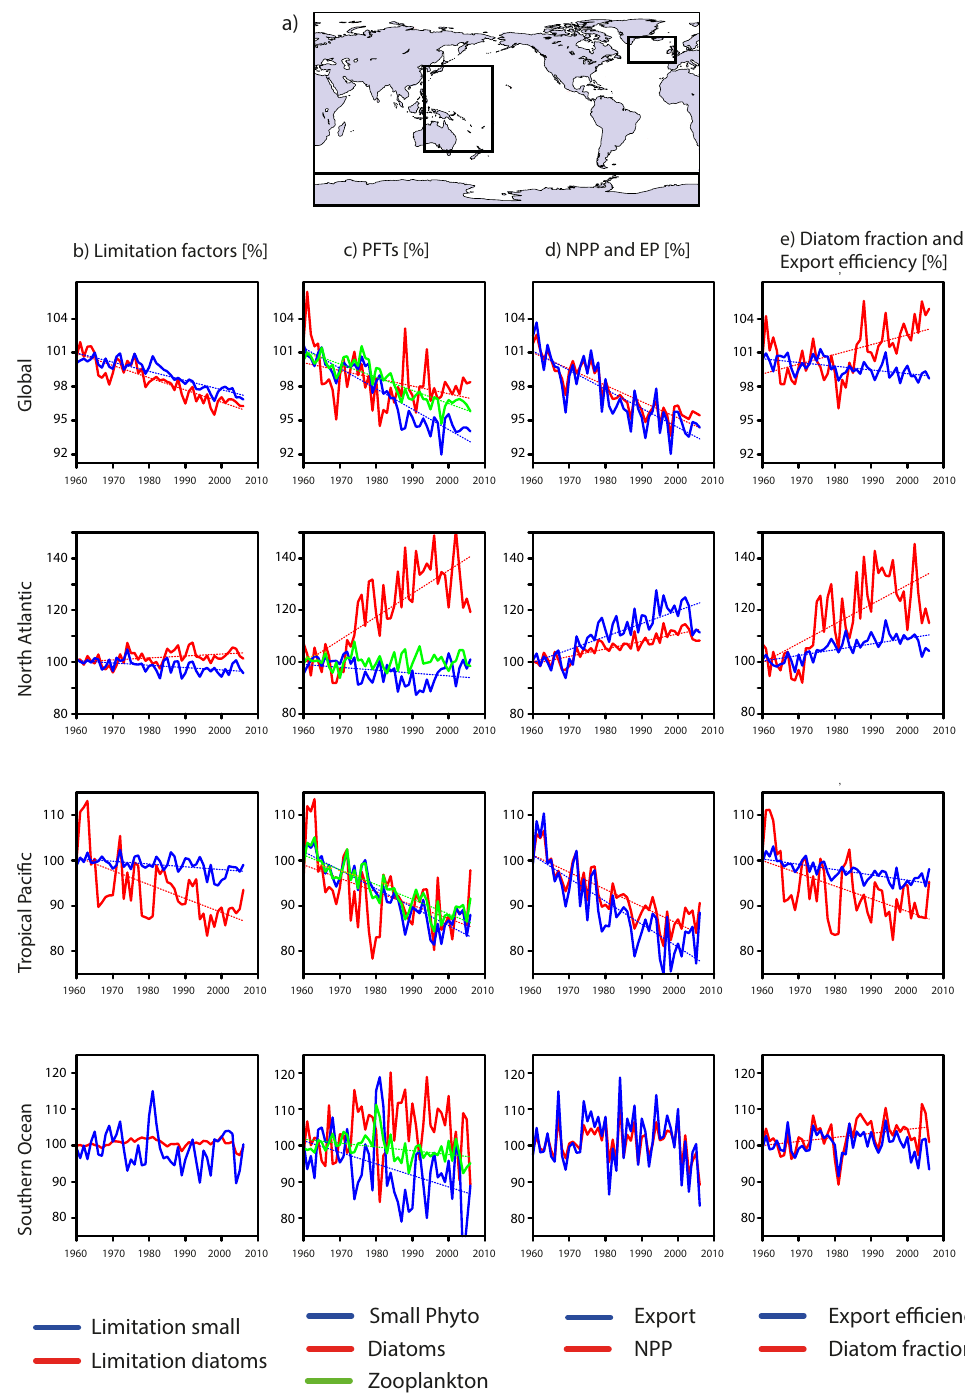
Fig. 2. Time series in percent for selected regions from 1960 to 2006. (a) Indicates the location of the different regions. Column (b) presents time series for the total limitation, with a higher limitation value leading to more production. Column (c) shows time series for PFT biomass, column (d) particle export production (EP) and integrated net primary production (NPP), and column (e) shows export efficiency and diatom fraction. Trends have been calculated with linear regression, using annual mean model output. Significance of trends has been tested with a t test ( p value of the regression is less than 0.05), for significant trends regression lines have been added. More details on calculation of trends are given in Sect.